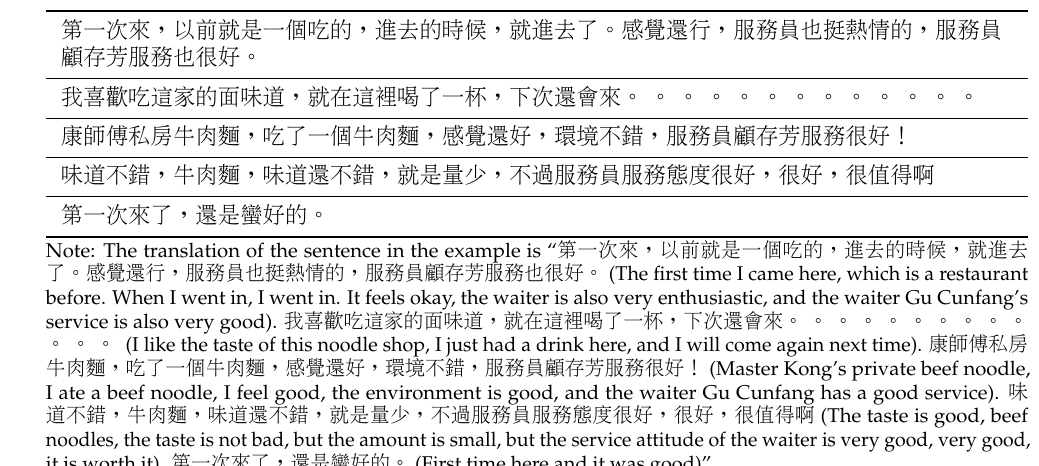
Table 2. An example of deceptive reviews generated by texgenrnn.